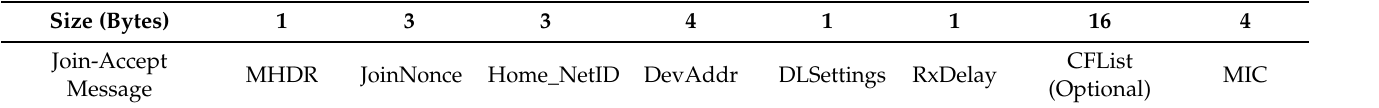
Table 3. Join-Accept